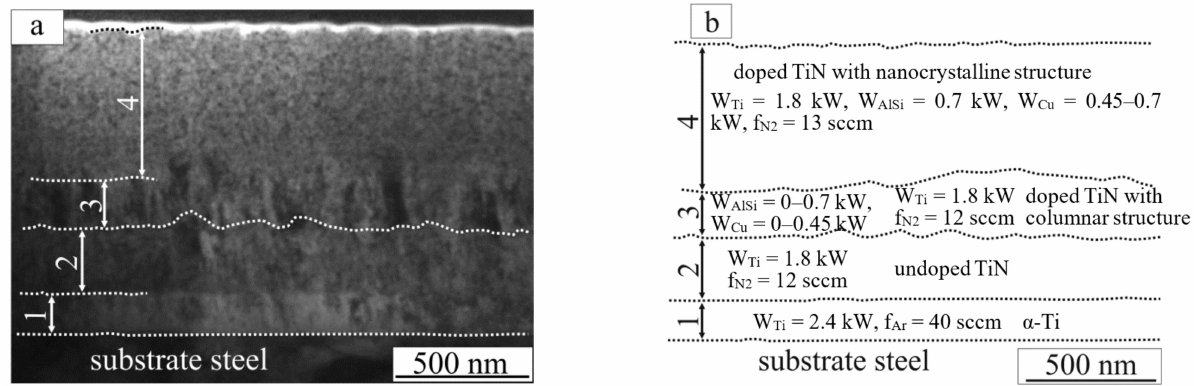
Figure 2. The bright-field image ( a ) of the structure of the gradient-laminated Ti-Al-Si-Cu-N coating and its scheme ( b ). Notation for ( a ): 1— α -Ti sublayer, 2—layer of non-alloyed TiN, 3—layer of alloyed TiN, 4—layer of alloyed TiN with nanocrystalline structure. Notation for ( b ): W—the power of the sputtering specific target, f—gas